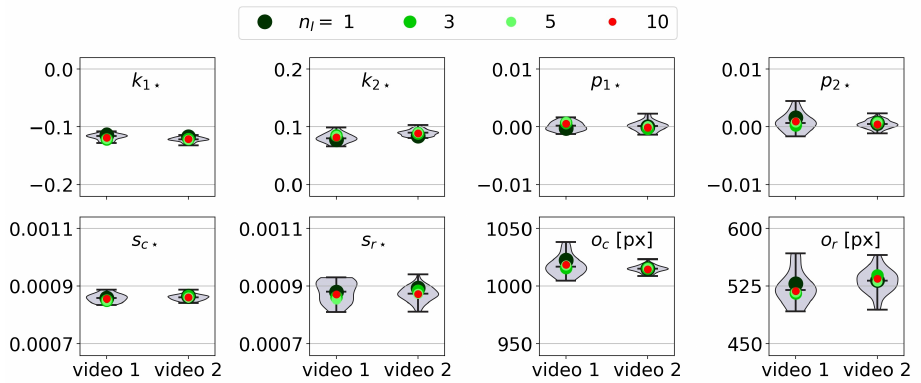
Figure 7. Intrinsic parameters for videos 1 video 2 obtained for different values of n I ∈ { 1,3,5,10 } . The distribution of the intrinsic parameters for other 30 randomly chosen frames is shown in gray.